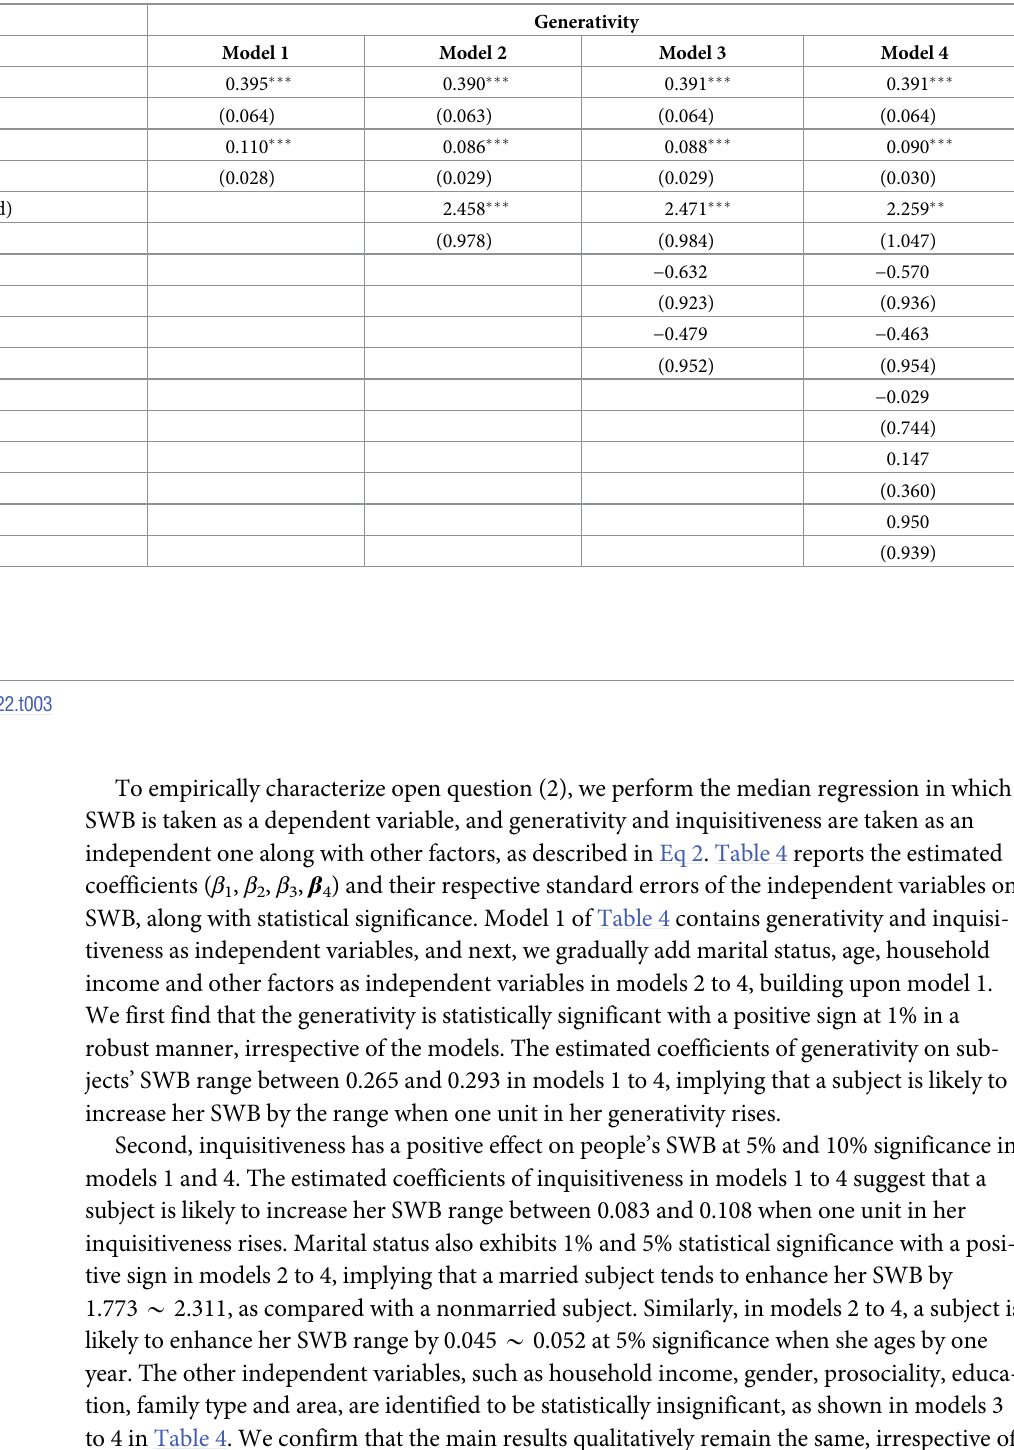
Table 3. Estimation results of OLS regression on people’s